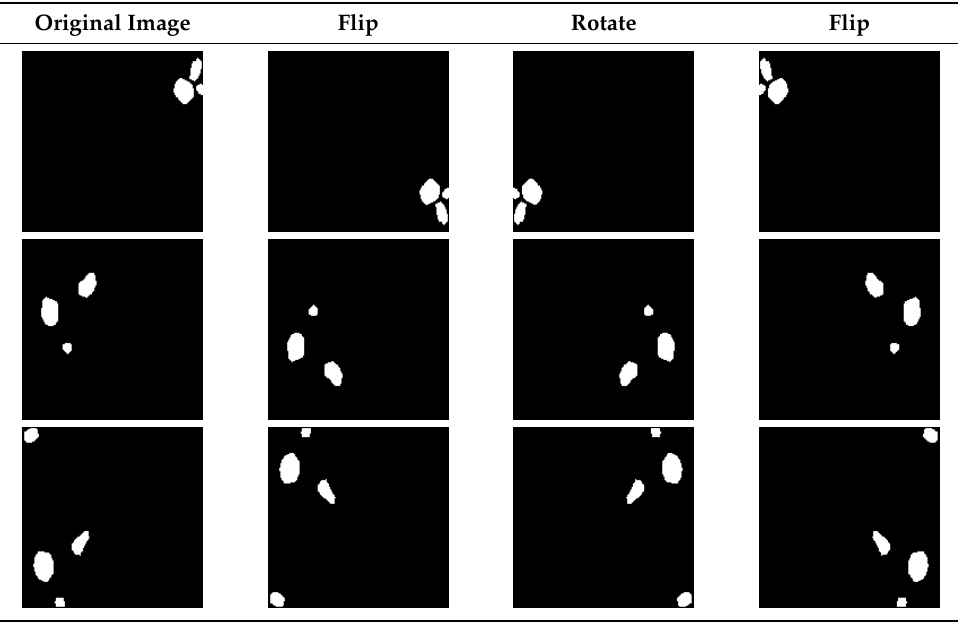
Figure 2. Images of the study area captured with the UAV. Table 1. Image operations for data